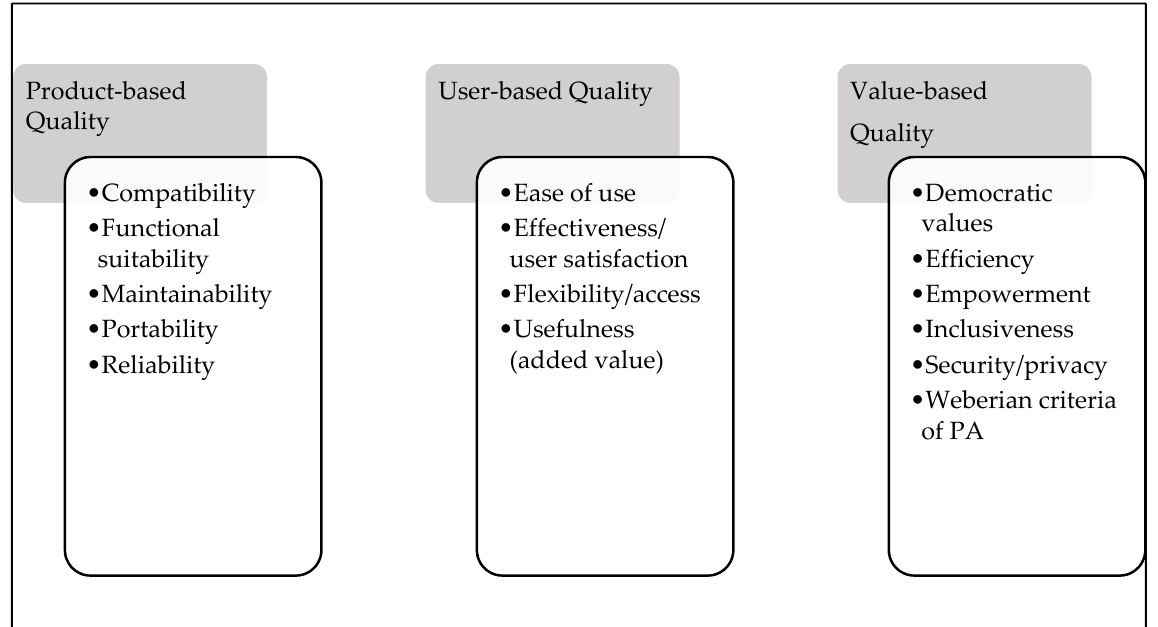
Figure 1. A multi-dimensional approach to the quality of digitally coproduced public services.